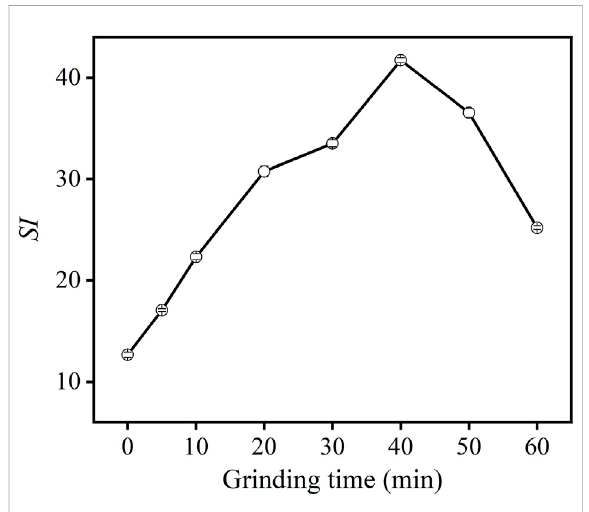
FIGURE 4 Effect of grinding time on SI of carbon anode slag fl otation (feed solid concentration 200 g/L, colletor dosage 1,000 g/t, frother dosage 500 g/t).